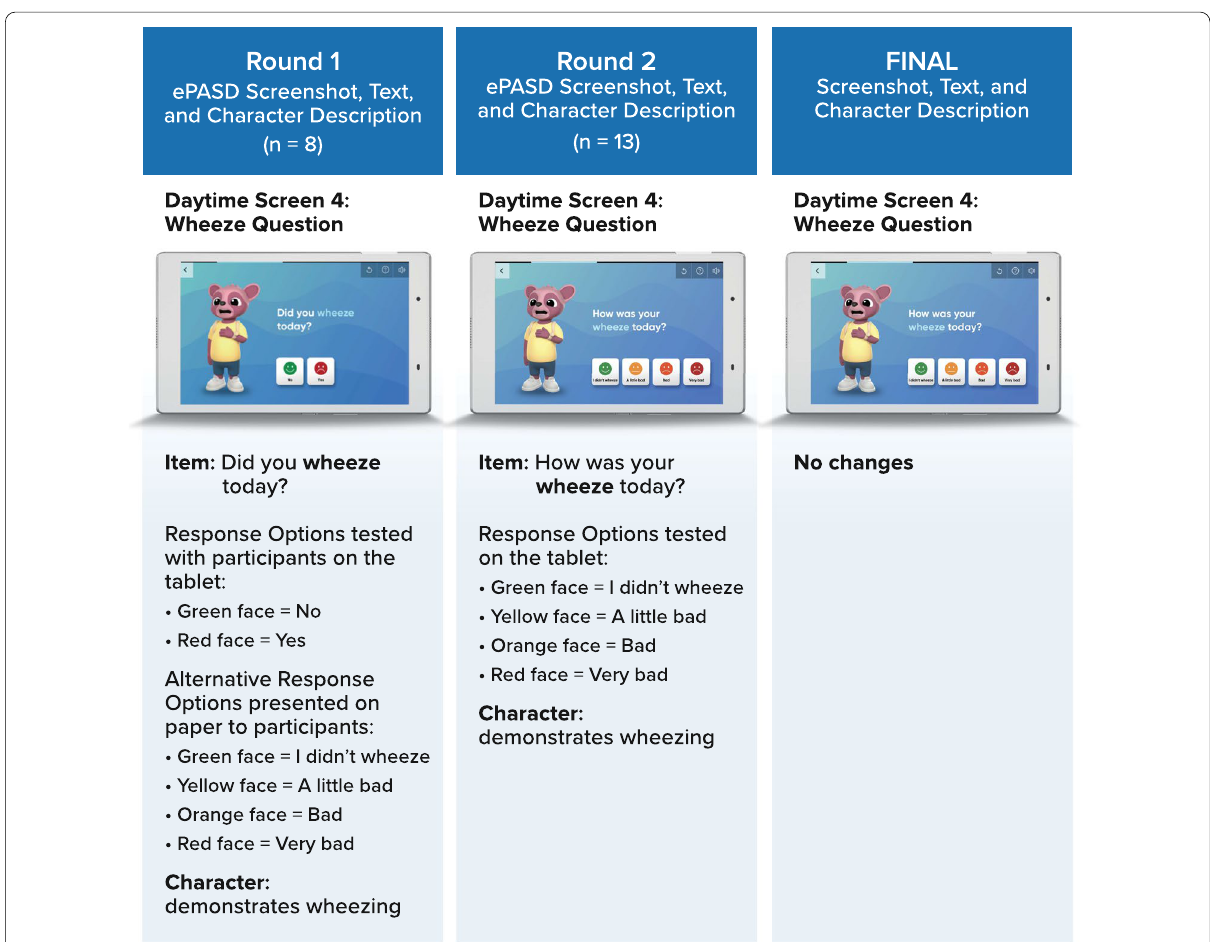
Fig. 3 Depiction of ePASD wheeze daytime item through each round of cognitive debriefing interviews and the final item version. ePASD electronic Pediatric Asthma Symptom Diary. Image reproduced with permission from Novartis Pharma